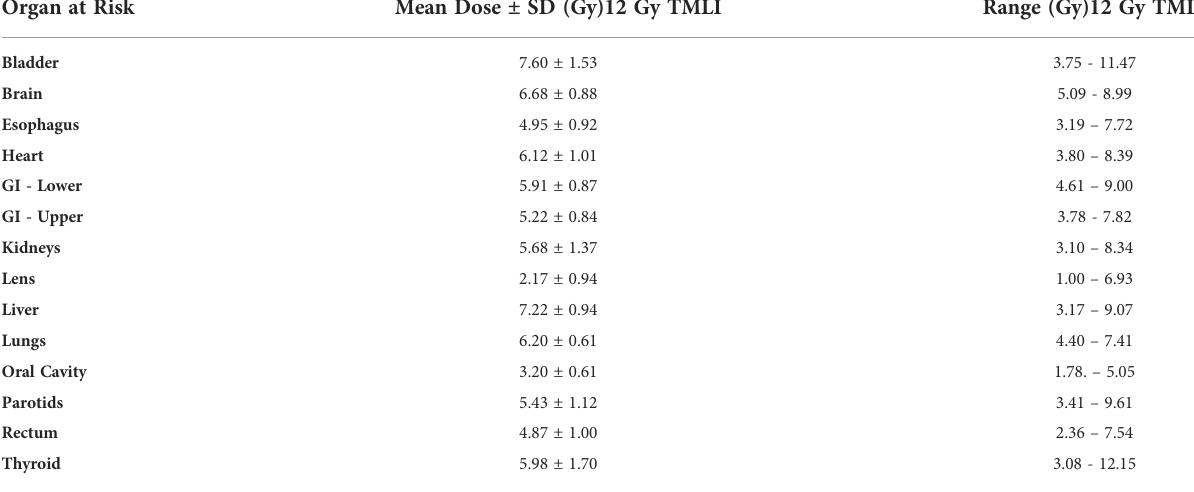
TABLE 1 Summary of mean organ dose (Gy) for patients treated with 12 Gy TMLI (n = 108). Organ at